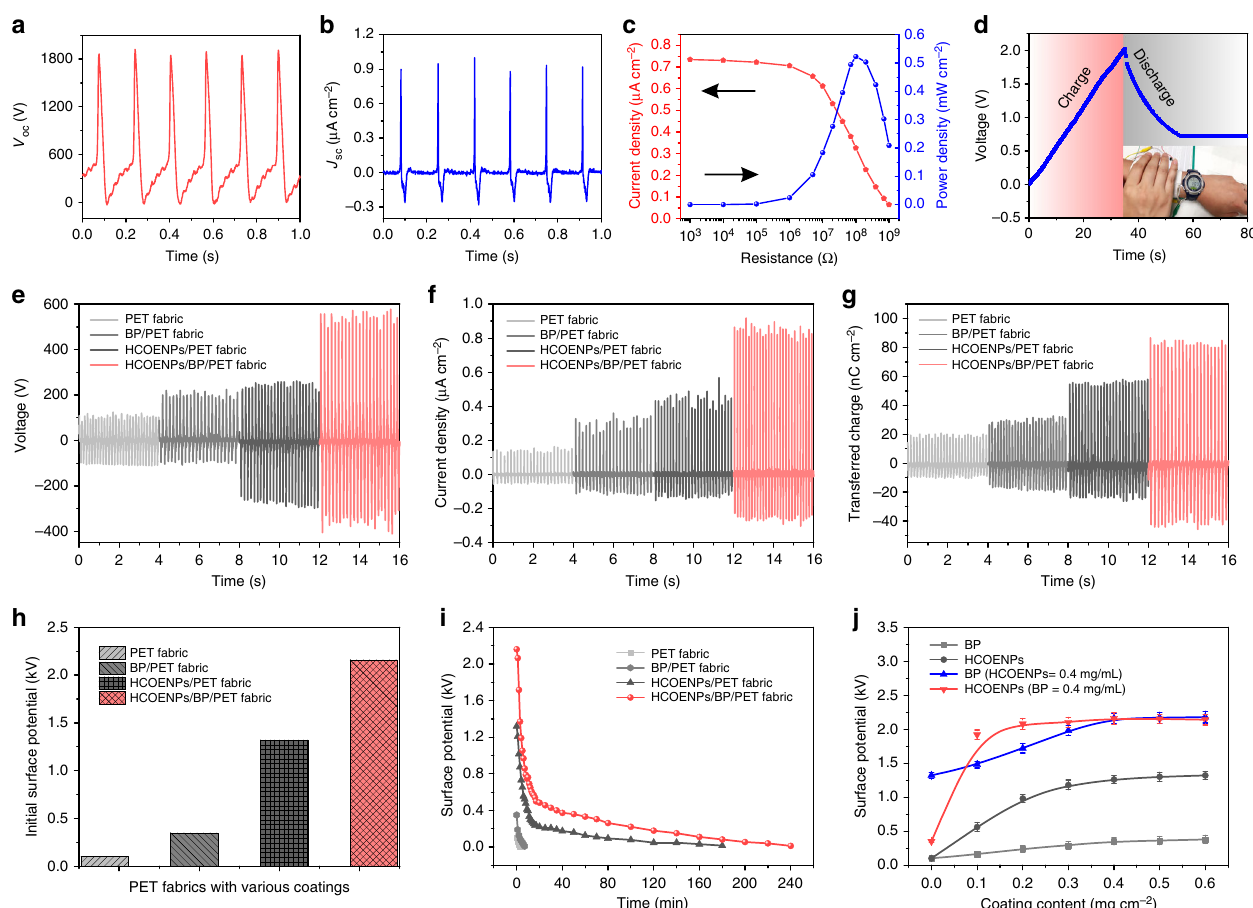
Fig. 2 Triboelectric performances of nanogenerators based on modi fi ed polyethylene terephthalate fabrics. a , b Open-circuit voltage ( V oc ) and short-circuit current density ( J sc ) generated by textile-triboelectric nanogenerator (TENG). c Dependence of current density and instantaneous power density of textile- TENG on the resistance of external load. d Textile-TENG (7 cm × 7 cm) harvest mechanical energy of hand motion (<5 N, 4 Hz) to charge a 22 µ F capacitor for driving a digital watch. e Output voltages, f current densities, and g transferred charges of textile-TENGs based on the bare polyethylene terephthalate (PET) fabric, black phosphorus (BP)-coated PET fabric (BP/PET fabric), hydrophobic cellulose oleoyl ester nanoparticles (HCOENPs)-coated PET fabric (HCOENPs/PET fabric), and HBP-fabric (HCOENPs/BP/PET fabric). 100 M Ω was used as load resistance for output voltage and transferred charge measurement. Operation was performed here by touch force of 5 N and touch frequency of 6 Hz. h The initially saturated surface potential of the four different PET-based fabrics. i The retention time of the surface potential of four fabrics after friction formed by touching. j Dependence of the fabric surface potential on the density of different coatings. Surface potentials are tested here by touching with 5 N and 6 Hz to ensure suf fi cient induced charges. Error bars represent twice the standard deviations